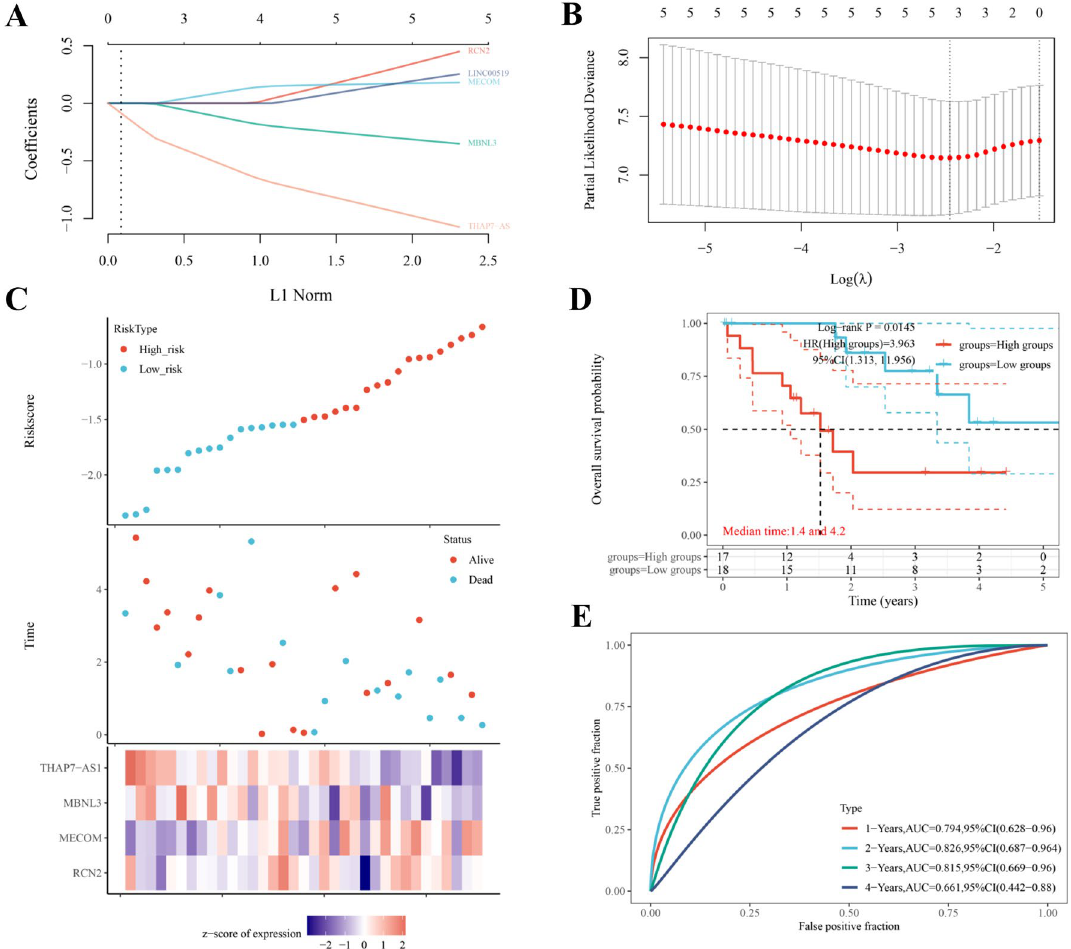
Figure 7. Construction of a prognostic risk model of five key RNAs by lasso regression and multifactorial cox using R “glment” package version 4.2–4, < URL: https:// glmnet. stanf ord. edu > . ( A ): scatter plot of the five RNA expression levels from low to high, with different colors representing different expression groups; ( B ) The relationship between partial likelihood deviation and log (l) was plotted using the Lasso Cox regression model. ( C ): Scatter plot distribution of survival time and survival status corresponding to sample RNA expression and expression heat map. ( D ): Overall survival probabilities of the four RNAs in different expression groups; the Log-rank p-value, HR, and 95% confidence interval are marked above it; ( E ): the below are ROC curves predicting 1-, 2-, 3- and 4-year survival based on the risk